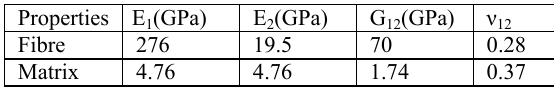
Table1. Mechanical properties of carbon fibre and matrix